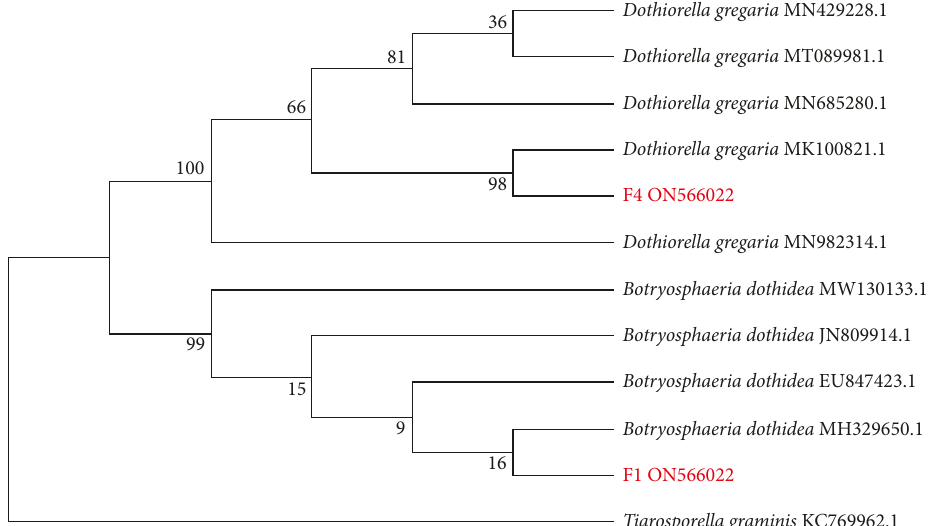
Figure 4: ML Phylogenetic tree based on ITS -rDNA gene sequence of kiwifruit fruit rot disease pathogen. Posterior probabilities from 1,000 bootstraps inferences are given node dates. The out group is Tiarosporella graminis . Table 3: The EC 50 values of the test fungicides and plant essential oils against Botryosphaeria dothidea and Dothiorella gregaria.